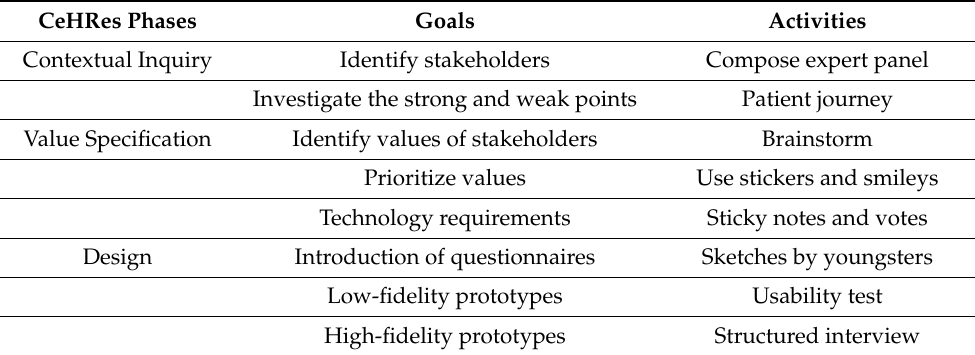
Table 1. Tools and techniques used during the development of INK.